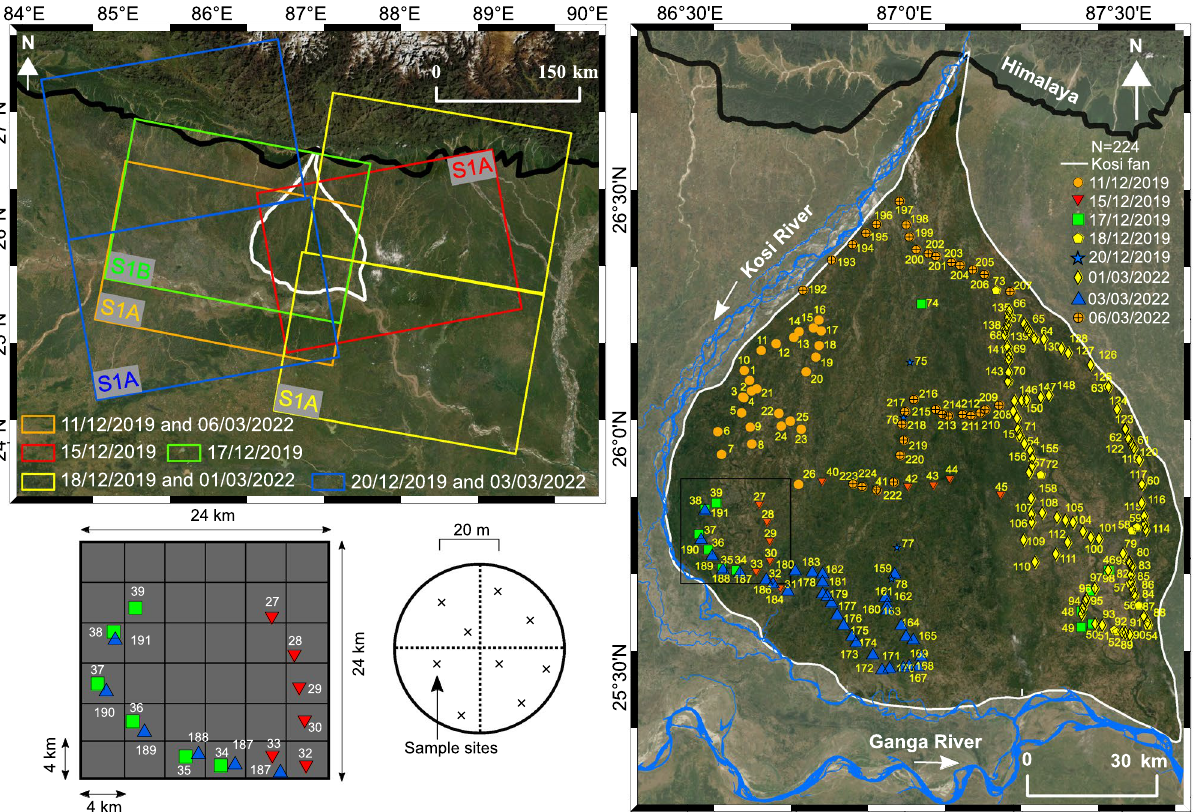
Figure 1. Image on the top left panel shows the rectangular footprints of the Sentinel-1 satellite images of different dates. The boundaries of the footprints are available at the European Space Agency Copernicus Open Access Hub website (https:// scihub. coper nicus. eu/). Image on the right panel shows the in-situ measured locations with sample ID (in different shapes) and their acquisition dates. The square grid on the bottom left panel illustrates the random sampling strategy. The maps are created in ArcGIS v10.8 software available at Environmental Systems Research Institute (ESRI) website (https:// www. esri. com/ en- us/ arcgis/ about- arcgis/ overv